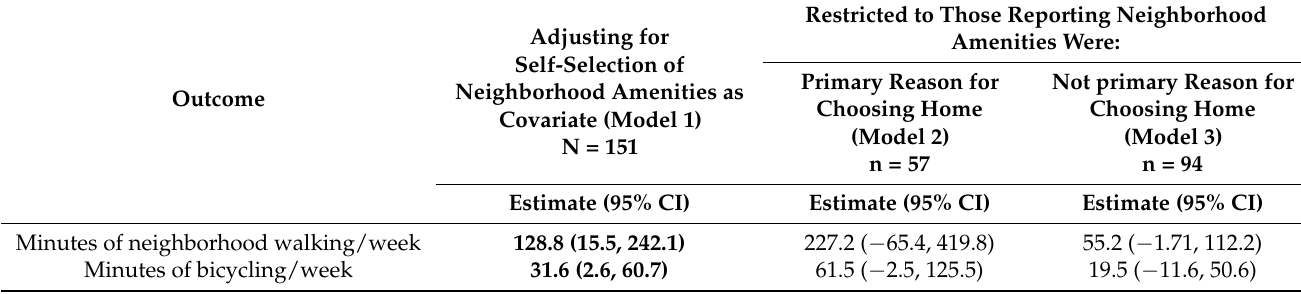
All linear regression models (n = 151) controlled for age, sex, education, income, race/ethnicity, children living in household, married/with partner, employed, always drive places, appraisal of neighborhood availability of parks/open space and ability to walk to shops/dining; Model 1 additionally controlled for self-selection of home due to nearby neighborhood amenities. Bold = statistically significant at p < 0.05. The multivariable model that did not control for self-selection and did not employ inverse probability weights demonstrated associations between living in Abacoa and more walking and bicycling per week (walking estimate: 132.1, 95% CI: 19.4, 244.8;